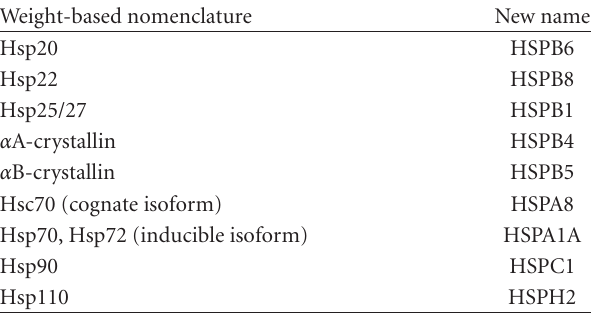
Table 1: Heat shock protein nomenclature. Comparison of the old molecular-weight-based names with the new nomenclature as outlined in Kampinga et al.